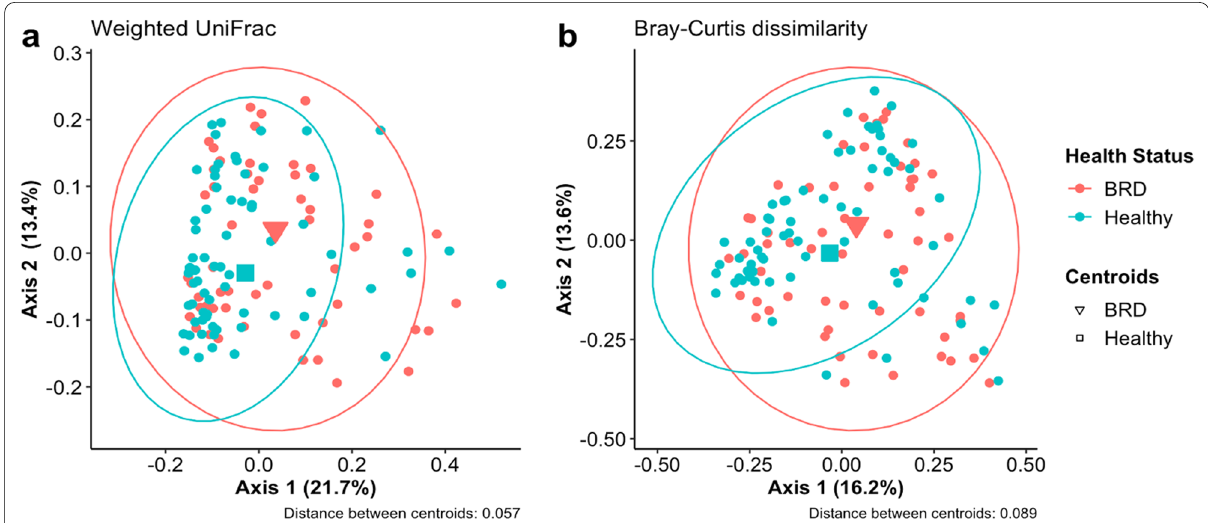
Fig. 2 Principal coordinate analysis (PCoA) of Weighted UniFrac distances ( a ) and Bray–Curtis dissimilarity ( b ) between BRD and healthy animals. Ellipses indicate a 95% confidence interval of individuals belonging to each health status group. Axis 1 represents the axis that explains the greatest amount of the variation followed by Axis 2. Larger points indicate the centroids of the ellipses. Distances of the centroids between the two groups are indicated in the caption below each